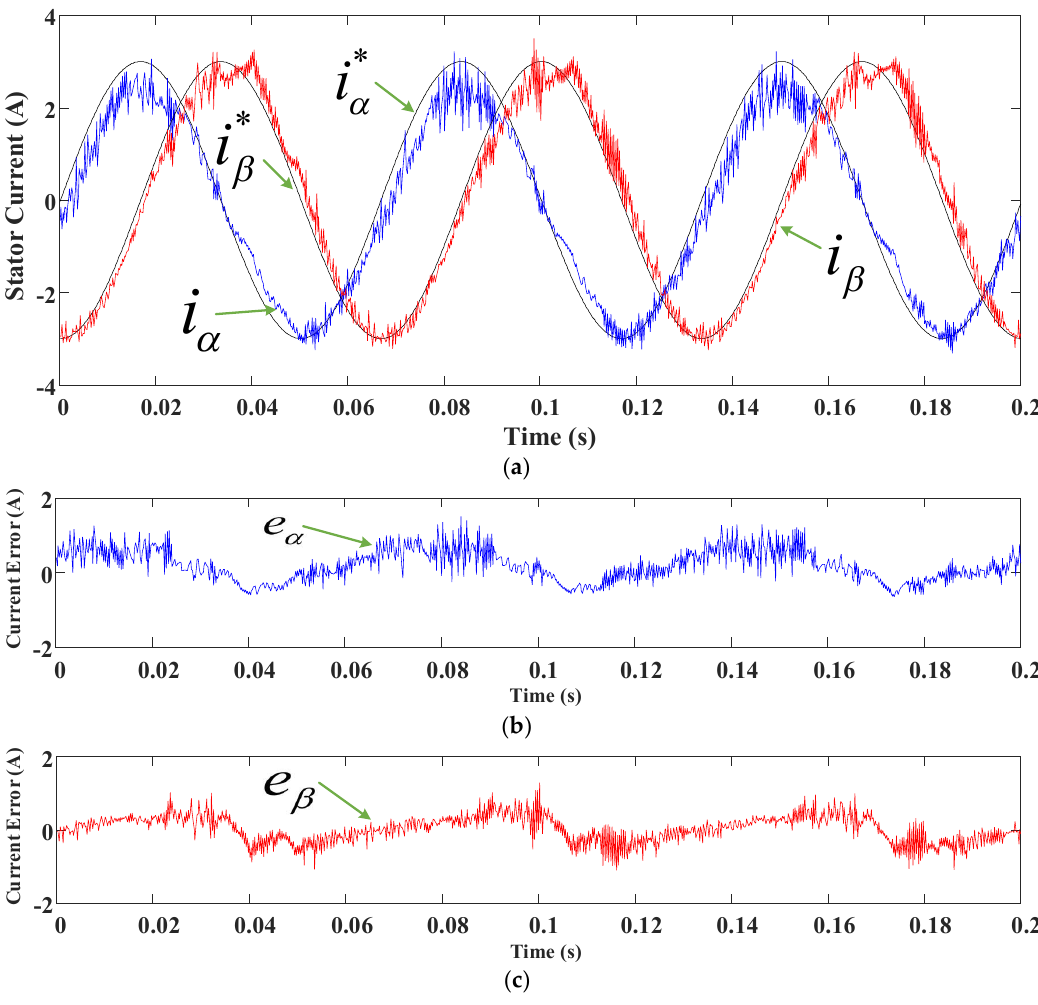
Figure 13. Experimental results of DVV-MPCC following a sinusoidal current command with amplitude 3 A and frequency 30 Hz (case 2): ( a ) current responses; ( b ) α -axis current error; ( c ) β -axis current error.